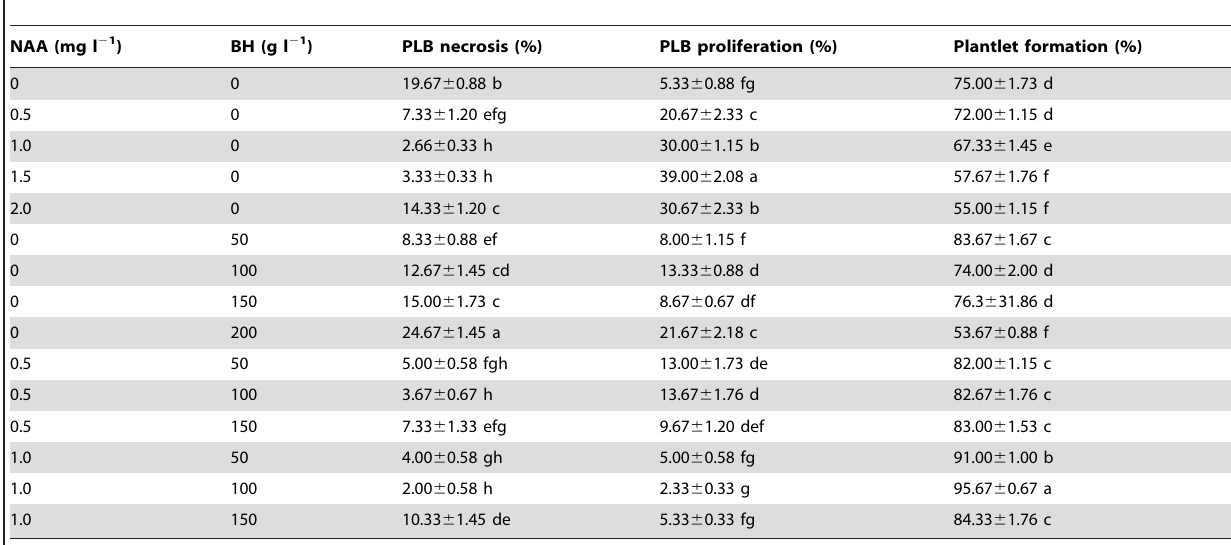
Table 5. Effect of NAA and banana homogenate (BH) concentration on differentiation of Renanthera imschootiana PLBs on 1/4 MS